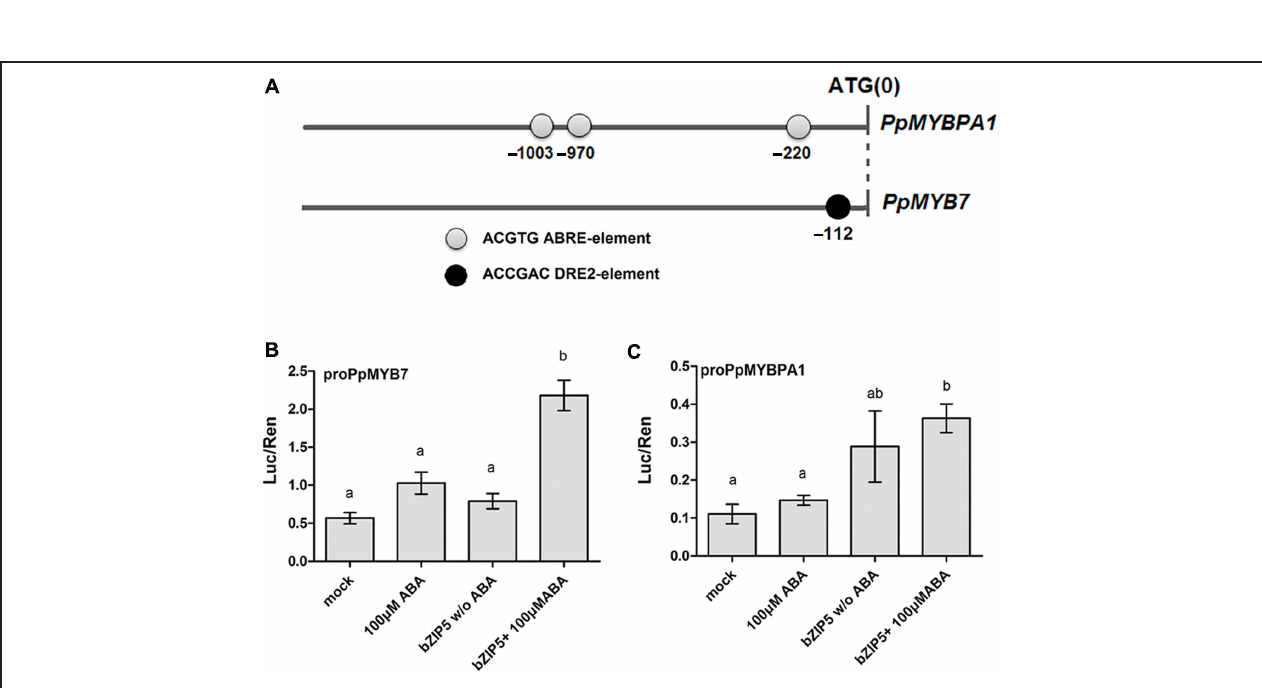
FIGURE 7 | Functional analysis of the promoter sequences of PpMYB7 and PpMYBPA1. (A) Cis -regulatory elements in the promoter sequences of PpMYBPA1 and PpMYB7 . (B,C) Analysis of the interaction of PpbZIP5 and ABA with the promoters of PpMYB7 and PpMYBPA1 in transiently transfected N. benthamiana leaves. Mock represents the control soaked in sterile distilled water. Different lowercase letters indicate the significant differences among treatments by Tukey’s test at P < 0.05. Error bars show SE of the mean (four biological replicates).